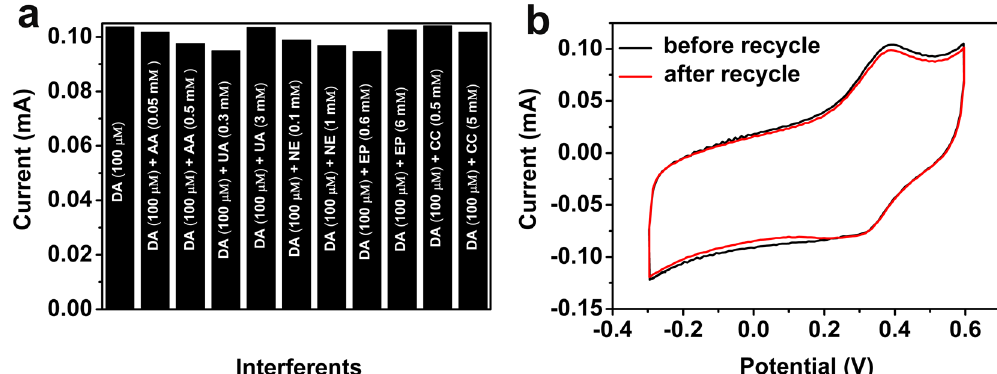
Figure 5. Specificity and reusability of the Pd/NPG wire biosensor. ( a ) Response currents of the Pd/NPG wire biosensor in the solution of 100 μΜ DA in the presence of AA, UA, NE, EP and CC. ( b ) The CV curves of Pd/ NPG wire biosensor before and after